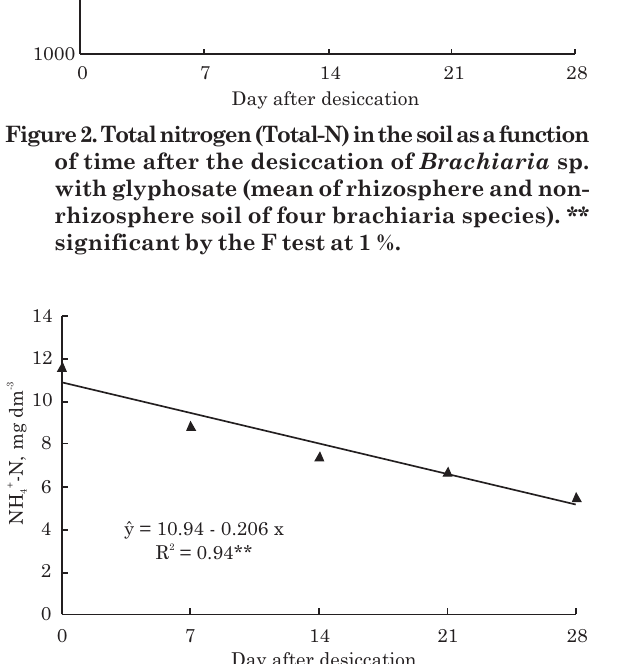
Figure 3. Ammonium (NH 4+ -N) in the soil as a function of time after the desiccation of Brachiaria sp. with glyphosate (mean of rhizosphere and non- rhizosphere soil of four brachiaria species). ** significant by the F test at 1 %.